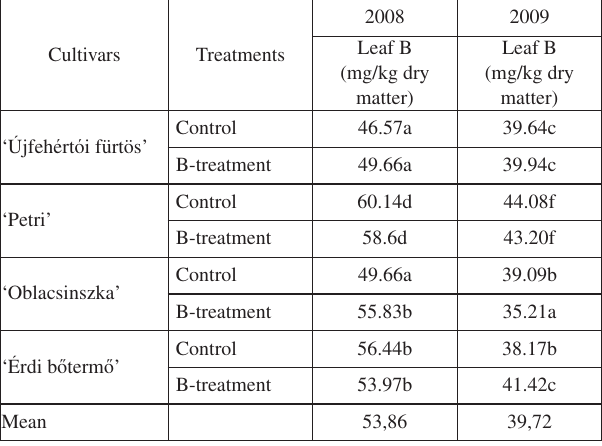
In each column, means followed by the same letter are not significantly different